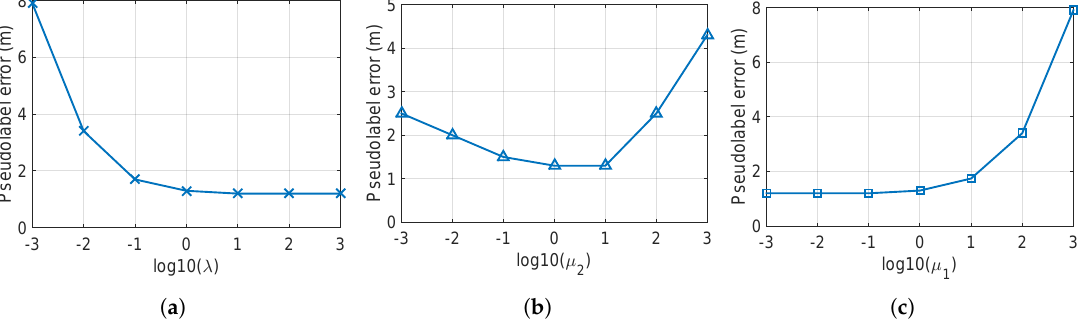
Figure 8. Impact of the parameters λ in Step 2, µ 2 , and µ 1 in Step 3 of Algorithm 1. ( a ) Impact of